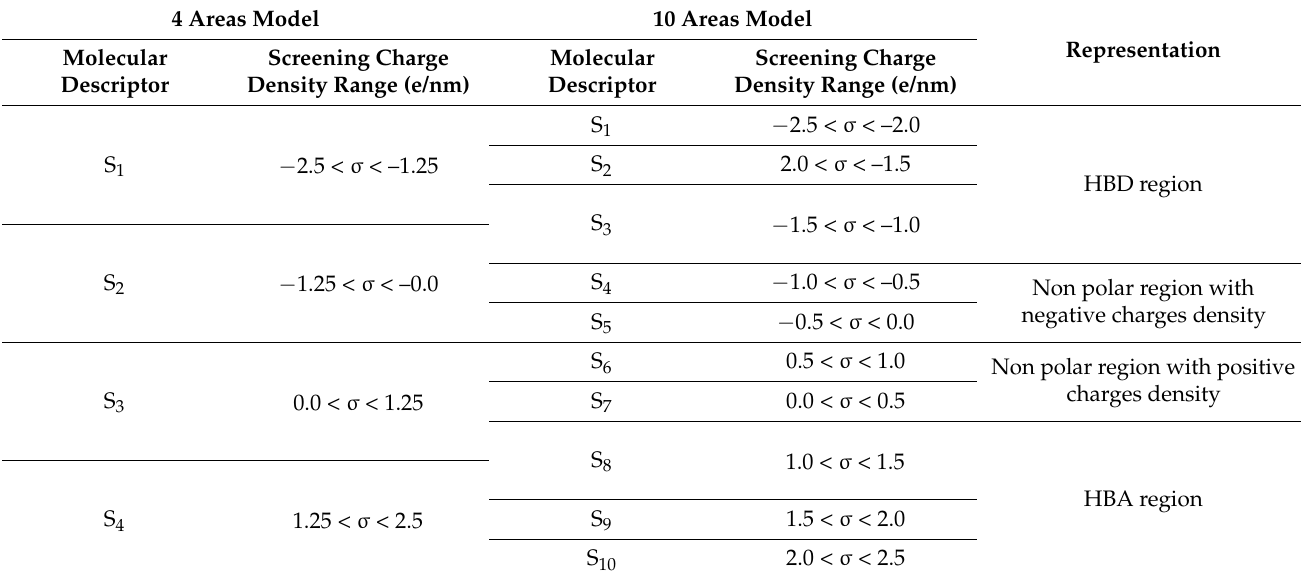
Figure 4. σ-profiles of rosmarinic acid (RA, red) and chlorogenic acid (CHA, blue) and its partition in ( a ) four intervals and ( b ) 10 intervals to generate the molecular descriptors. Table 3. Molecular descriptors for the 4 areas model and 10 areas model and their representations based on Lemaoui et al. representation [68].